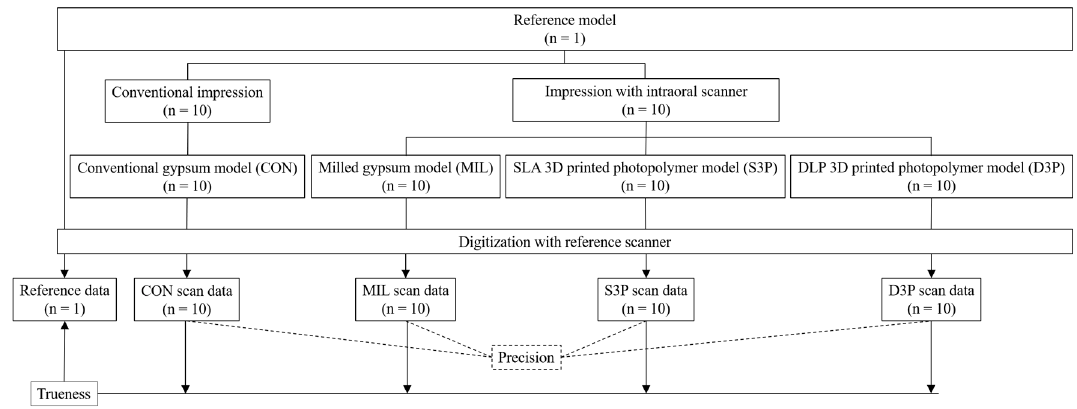
Figure 1. Flow-chart of the study design. SLA, stereolithography; 3D, three-dimensional; DLP, digital light processing.